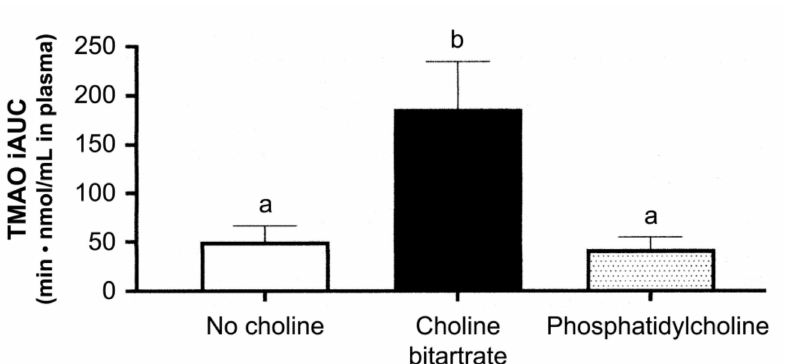
Figure 5. Plasma trimethylamine-N-oxide response to different meal consumptions as the incremental area under the curve (iAUC) across 6 h after ingestion. Different letters show a significant effect of the study meals (one-way) ANOVA. Values are mean ± SE, n = 37 per study. Different letters, mboxemphp < 0.01